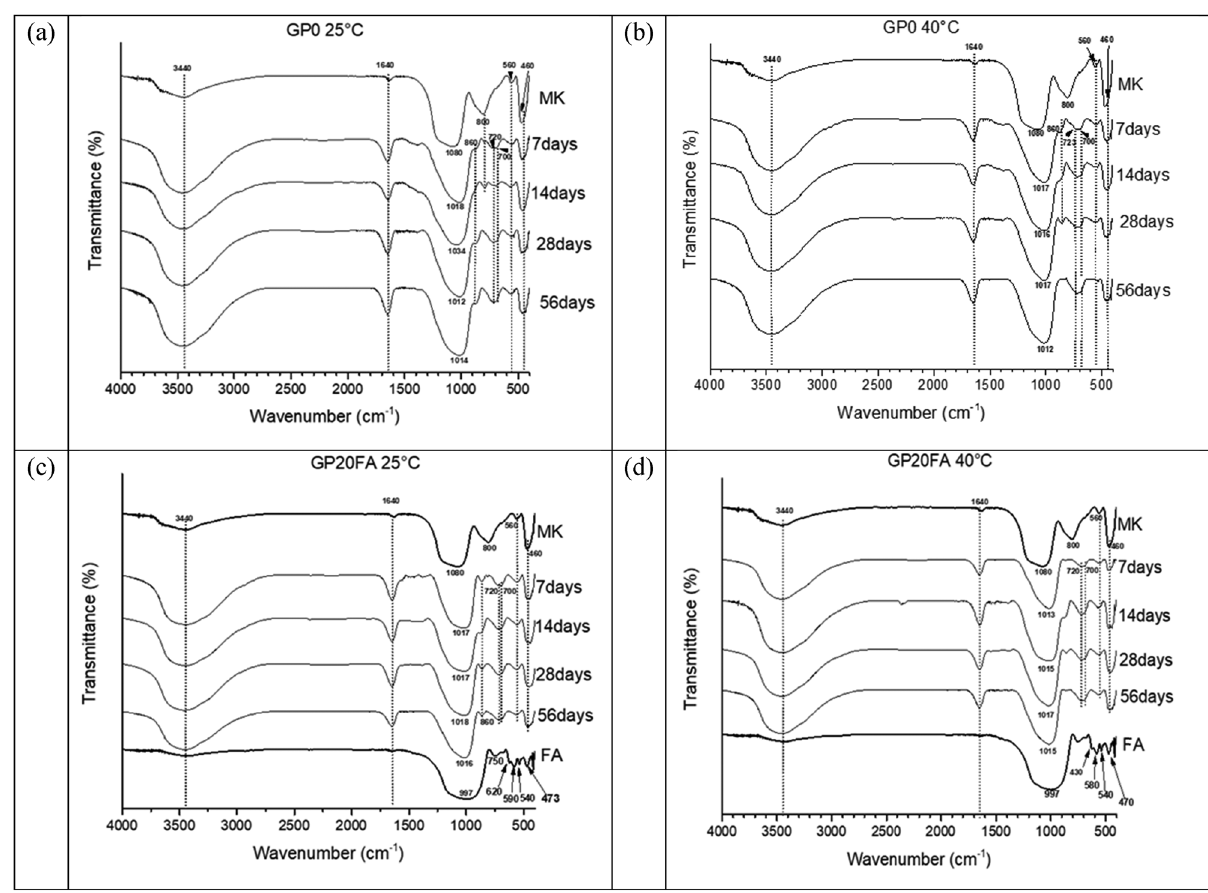
Figure 4: FT - IR spectra ( a ) GP0 at 25°C, ( b ) GP0 at 40°C, ( c ) GP20FA at 25°C, and ( d ) GP20FA at 40°C at di ff erent ageing times.